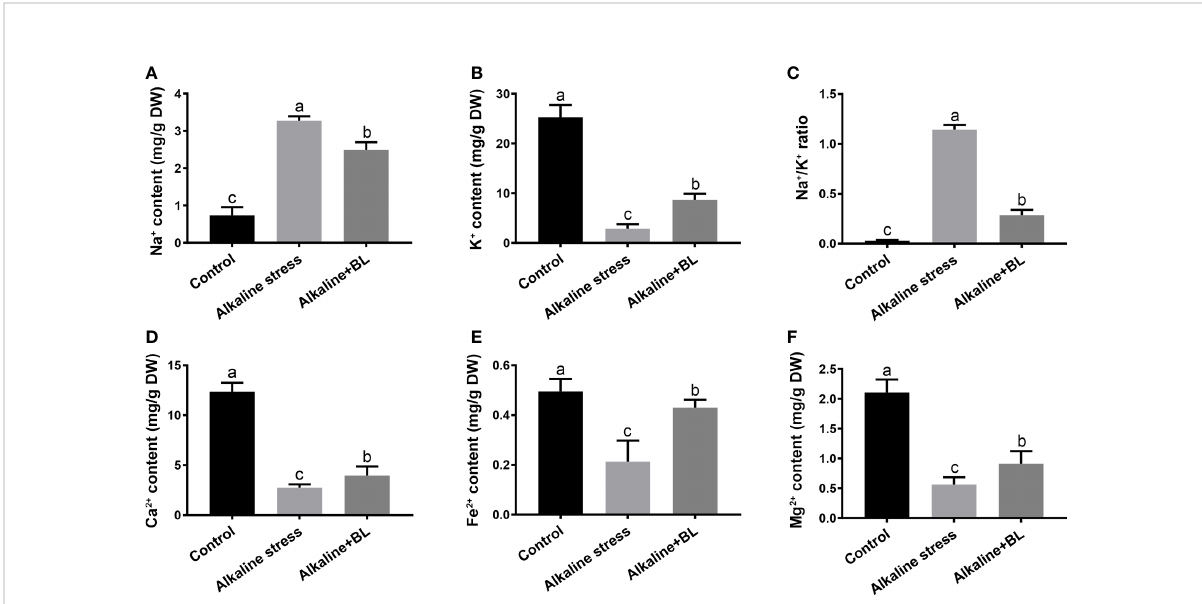
FIGURE 7 Effects of exogenous BL treatment on Na + content (A) , K + content (B) , and Na + /K + ratio (C) , Ca 2+ content (D) , Fe 2+ content (E) and Mg 2+ content (F) under alkaline stress. The data represent the mean ± SD of three biological replicates. Different lowercase letters indicate signi fi cant differences according to Fisher ’ s least signi fi cant difference ( P < 0.05).